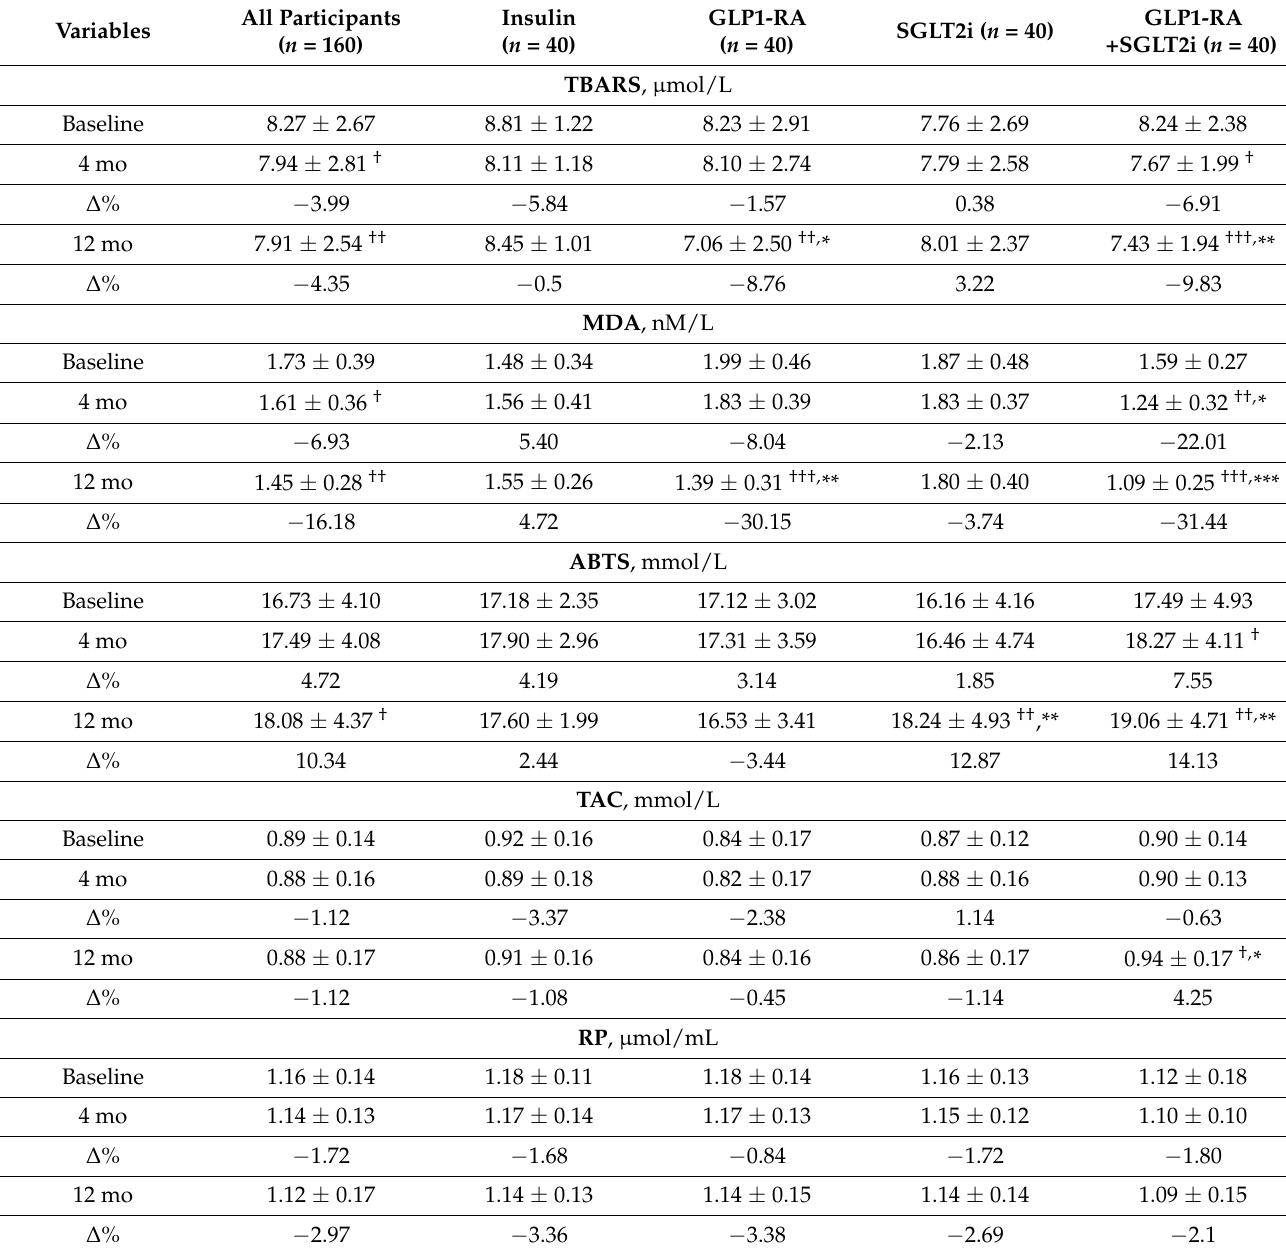
the change of BMI posttreatment (F = 5.939, P for interaction = 0.002; Table 2). Patients treated with combination of GLP-1RA+SGLT-2i presented a greater percentage reduction of BMI compared with GLP-1RA ( p = 0.042) or SGLT-2i ( p = 0.009; Table 2) Total cholesterol, low-density lipoprotein cholesterol, and triglycerides blood levels were decreased in all groups at 4 and 12 months post-treatment ( p < 0.01; Table 2). Table 2. Changes in the circulating levels of oxidation stress and antioxidant